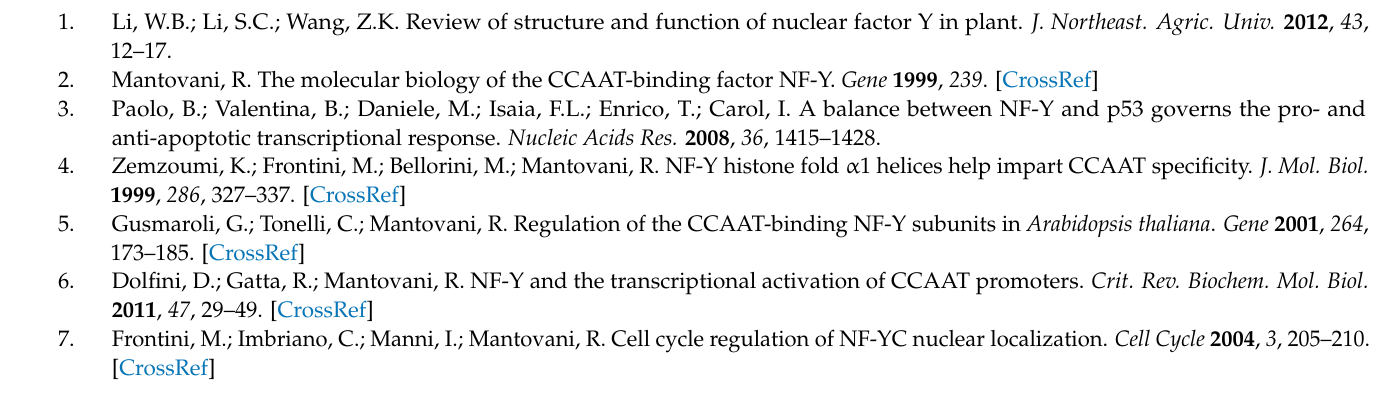
grandis , Figure S2: Multiple sequence alignment of EgNF-YB conservative domains., Table S1: EgNF- YB gene information, Table S2: Primer sequence were used for q-PCR